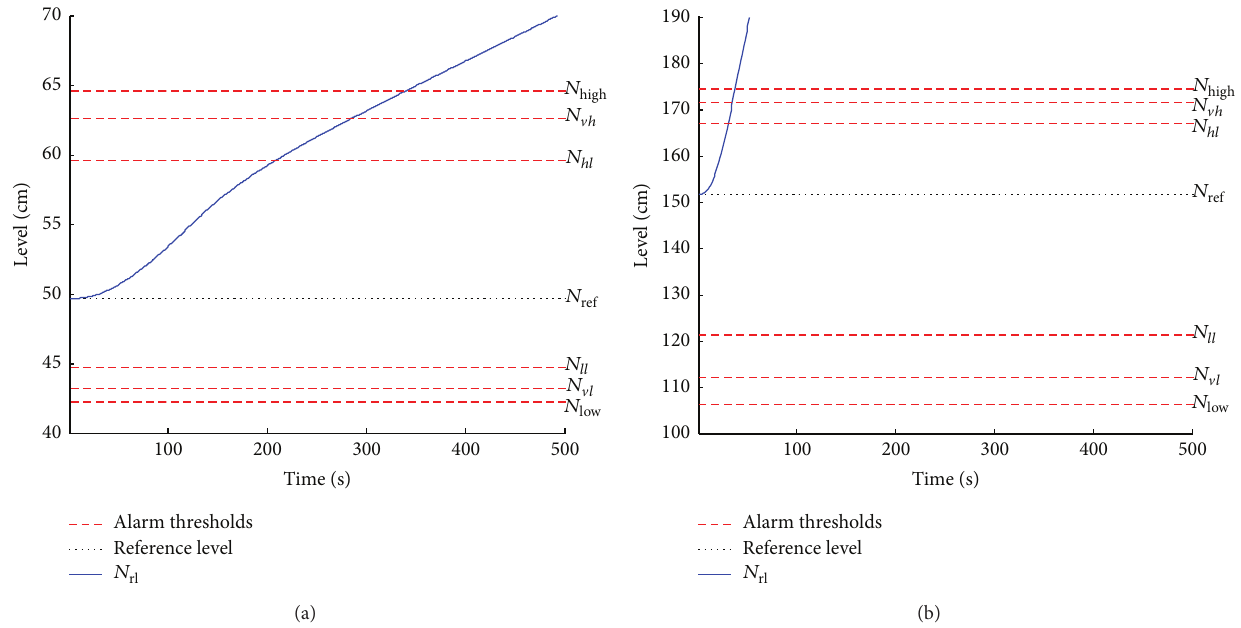
Figure 17: 𝑁 evolution when the PID controller output is stuck at time 𝑡 = 0 at the minimum allowable value of − 18% of nominal 𝑄 𝑒 that rl should be provided at 5% 𝑃 𝑛 (a) and at 80% 𝑃 𝑛 (b).